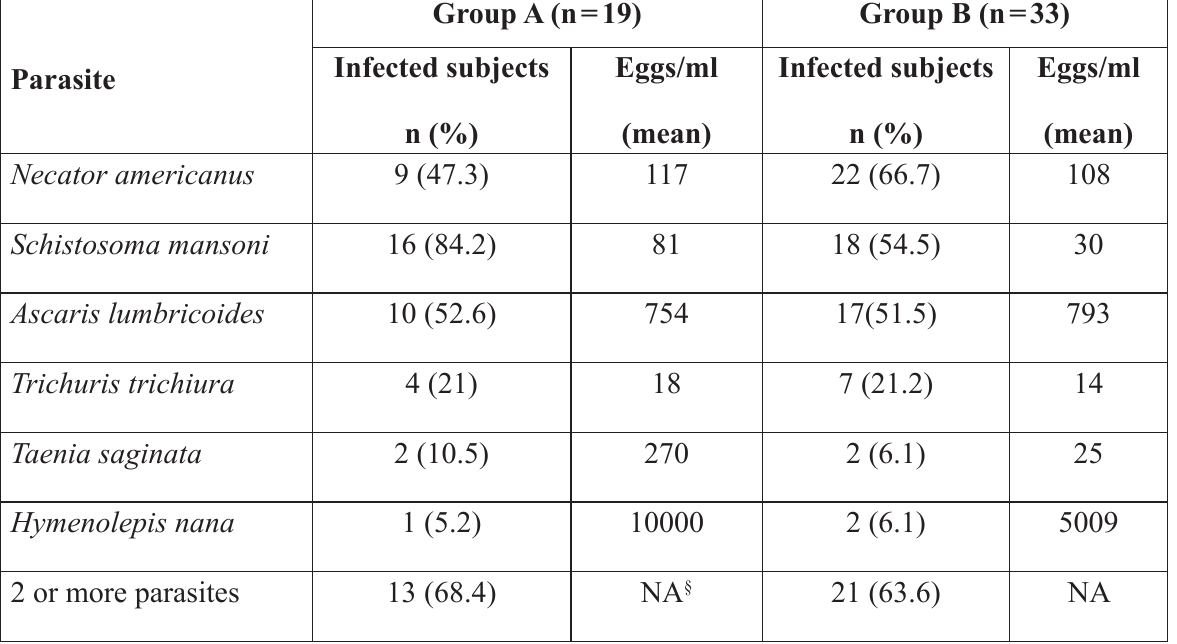
Table 1 . Parasite distribution and intensity of infection in Group A (in which helminths were not eradicated) and Group B (in which helminths were